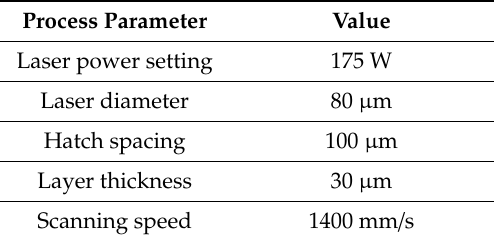
Table 1. DMLS process parameters.